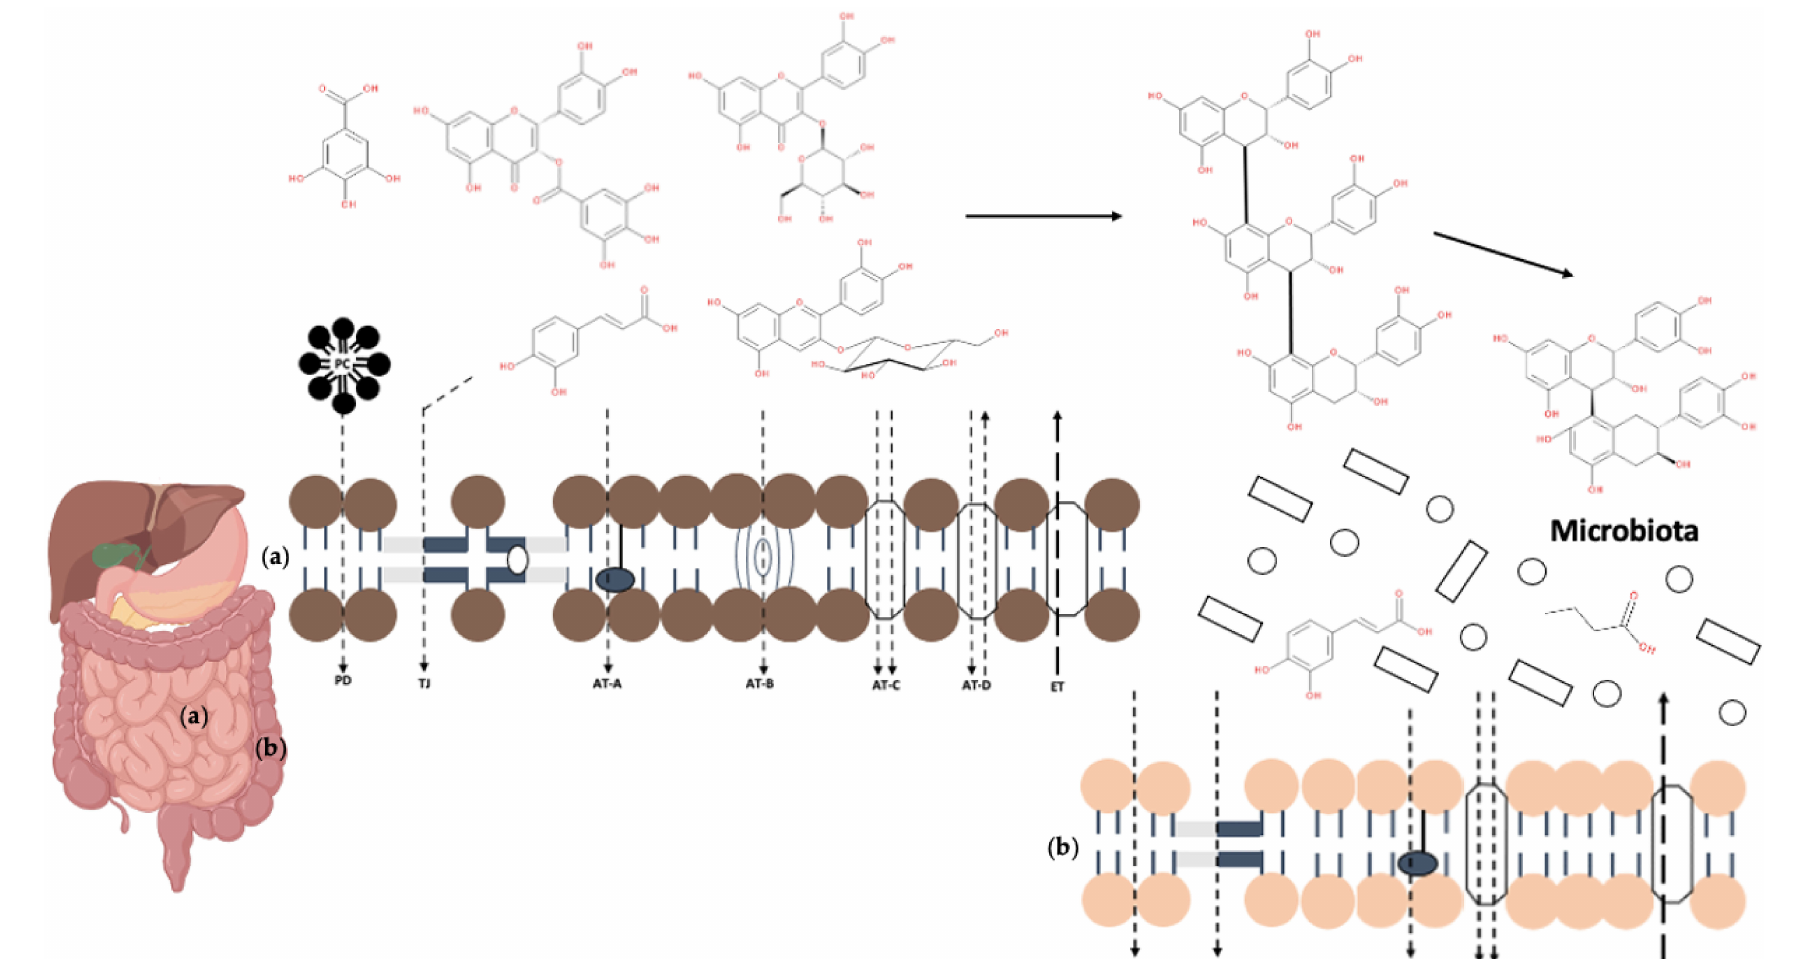
Figure 1. The hypothetical phenolic transport mechanisms as adapted with light modifications by the illustration in the work of Dom í nguez-Avila et al. [4] in ( a ) small intestine and ( b ) large intestine, where PD corresponds to passive diffusion; TJ to paracellular in tight junctions; ET to efflux transport; and AT-A, AT-B, AT-C, and AT-D to single-solute, translocase-type, co-solute symporter, and antiporter active transporters, respectively. Reproduced from Ref. [4] with permission from the Royal Society of